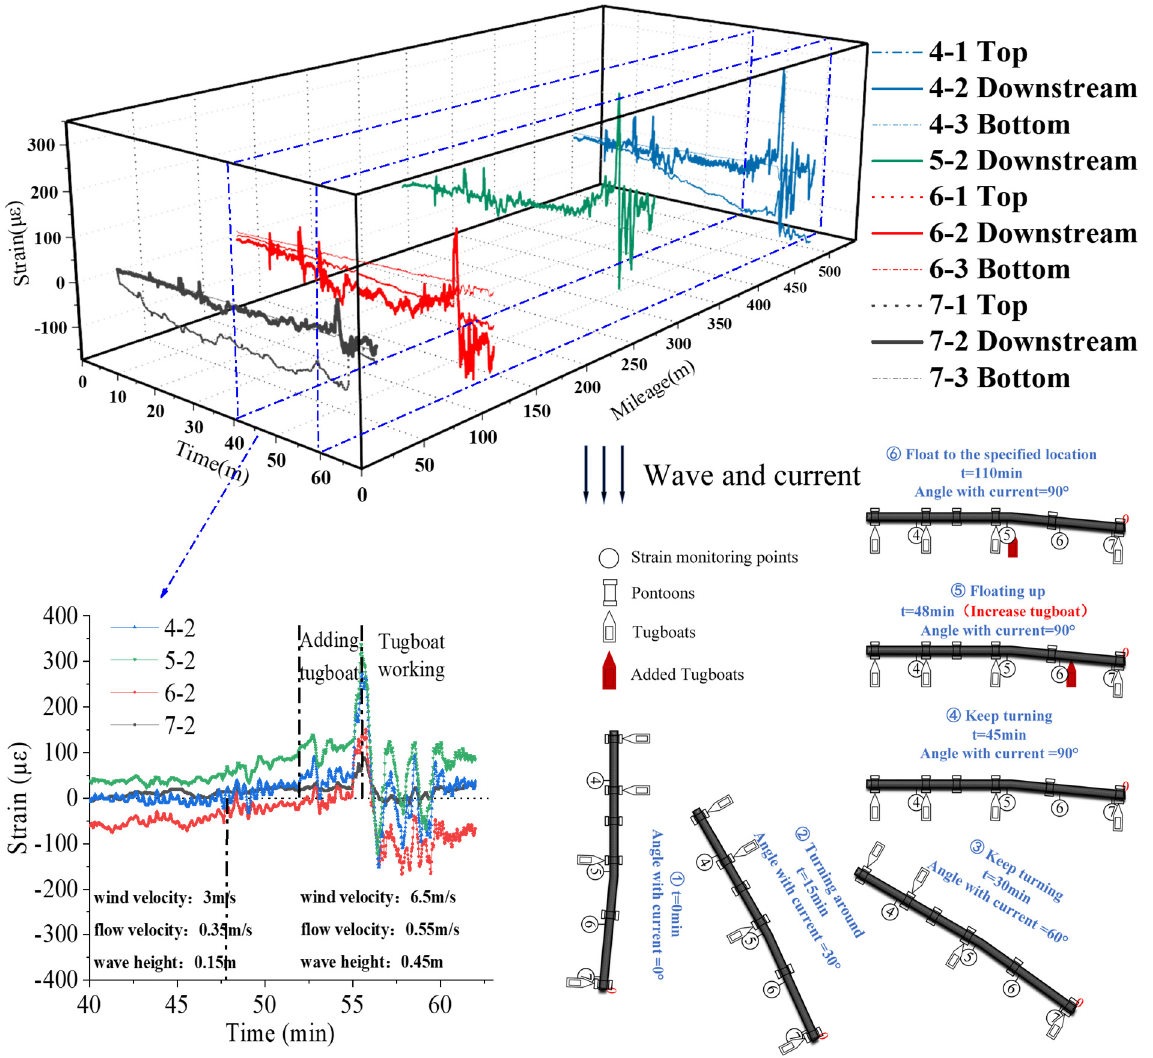
Figure 11. Dynamic floating construction of pipeline Section 2.